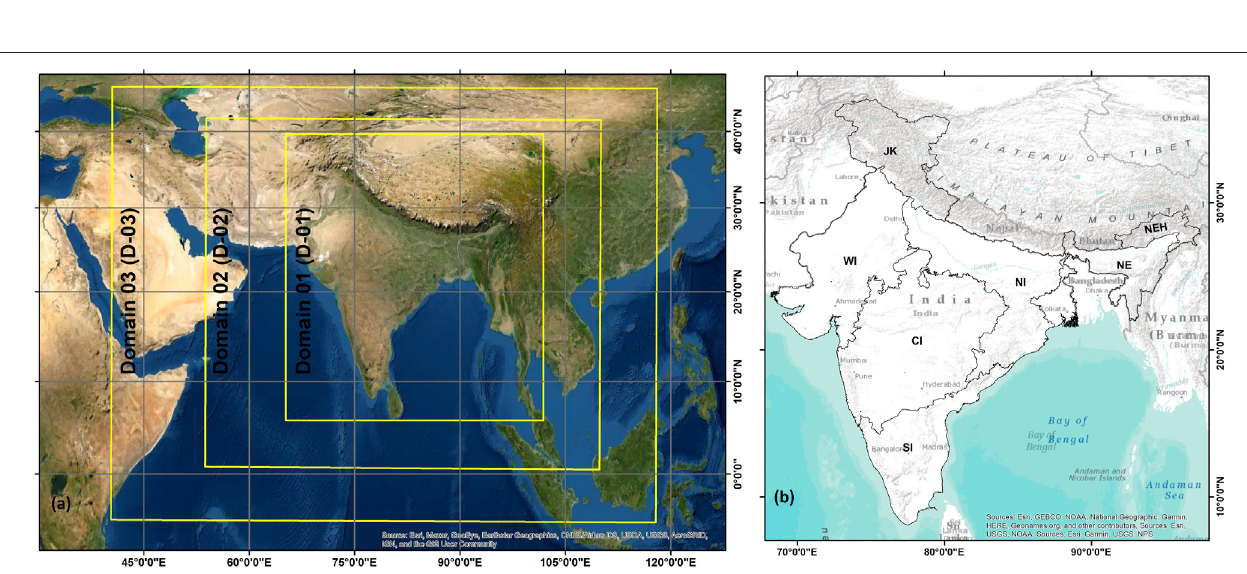
Frontiers in Environmental Science |